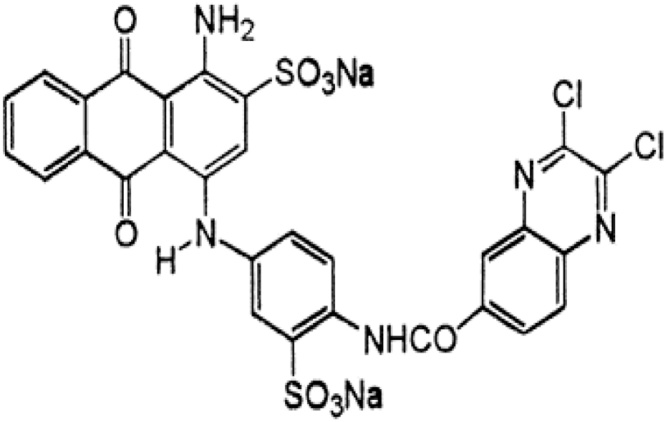
Structural formula of Reactive blue 29 [11].